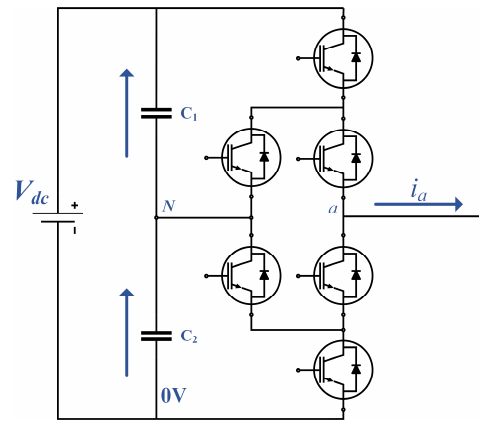
Figure 11. 3L-ANPC phase leg.